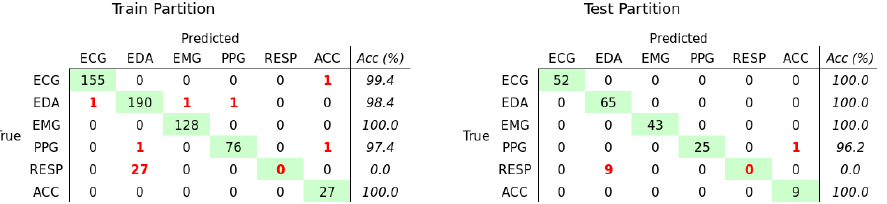
Figure 2. Confusion Matrices that show the result of the classification of the type of signal, on the train ( left ) and test ( right ) partitions. On the diagonal (green), the numbers of correctly classified samples for each type of signal. Out of the diagonal, in red, the numbers of mis-classified samples.